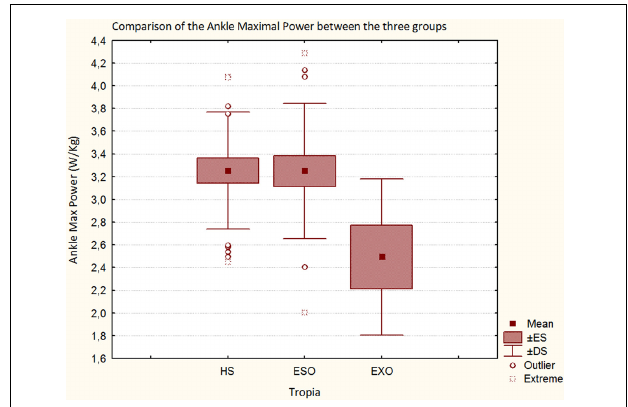
FIGURE 4 | Maximal Power at the ankle in HS, in patients with ESO and in patients with EXO.